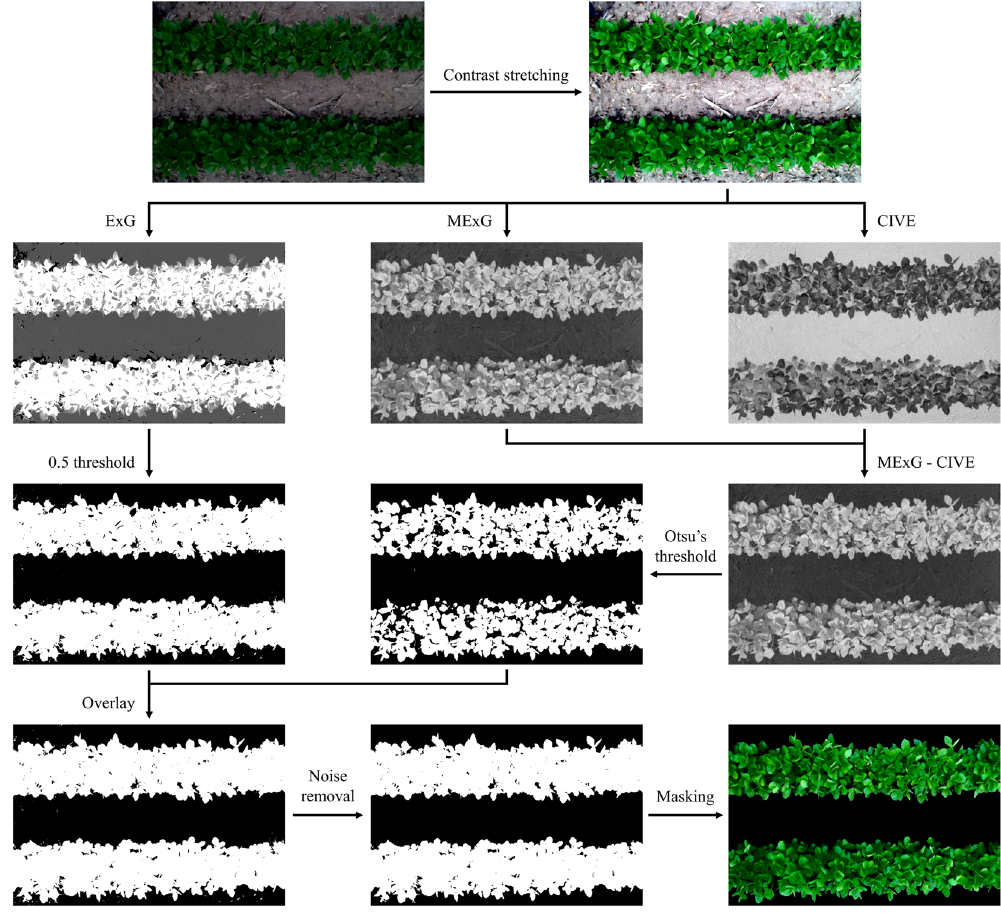
Figure 5. Flowchart of image